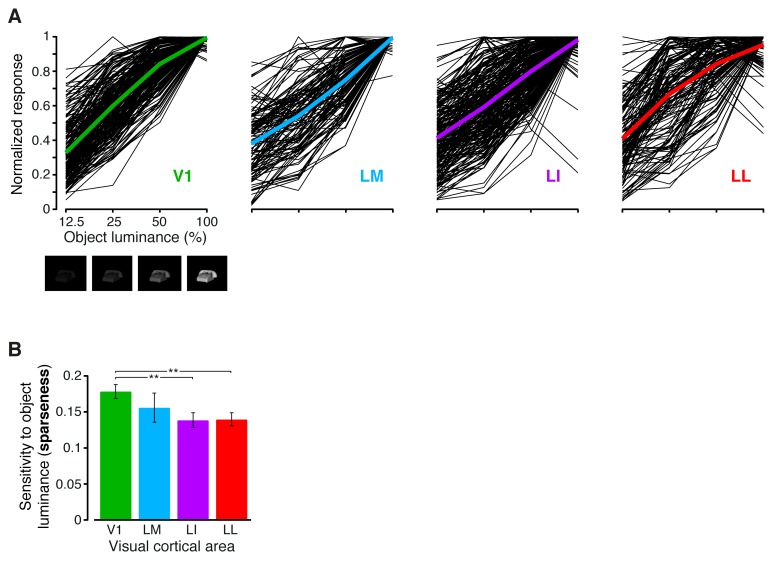
Sensitivity of rat visual neurons to luminance variations of the same object.(A) The thin black curves show the sensitivity to luminance variations of the same object for the neurons recorded in each area. Each curve was obtained by taking, for each neuron, the responses across the four luminance levels that were tested for each object (i.e., 12.5%, 25%, 50% and full luminance; see the example images reported below the abscissa in the leftmost panel), and then averaging these responses across the 10 object identities. This yielded a curve showing the average response of the neuron to each luminance level. Each curve was then normalized to its maximum, so as to allow a better comparison among the different neurons in a given area. The colored curves show the averages of these luminance-sensitivity curves across all the neurons recorded in each area. Note that the luminance levels on the abscissa are reported on a logarithmic scale. (B) For each neuron, the sharpness of its sensitivity to luminance changes of the same object was quantified by computing the sparseness of the black curves shown in (A). The bars show how the sparseness decreased across the four visual areas (median over the units recorded in each area ± SE; **p<0.01, 1-tailed U-test, Holm-Bonferroni corrected).